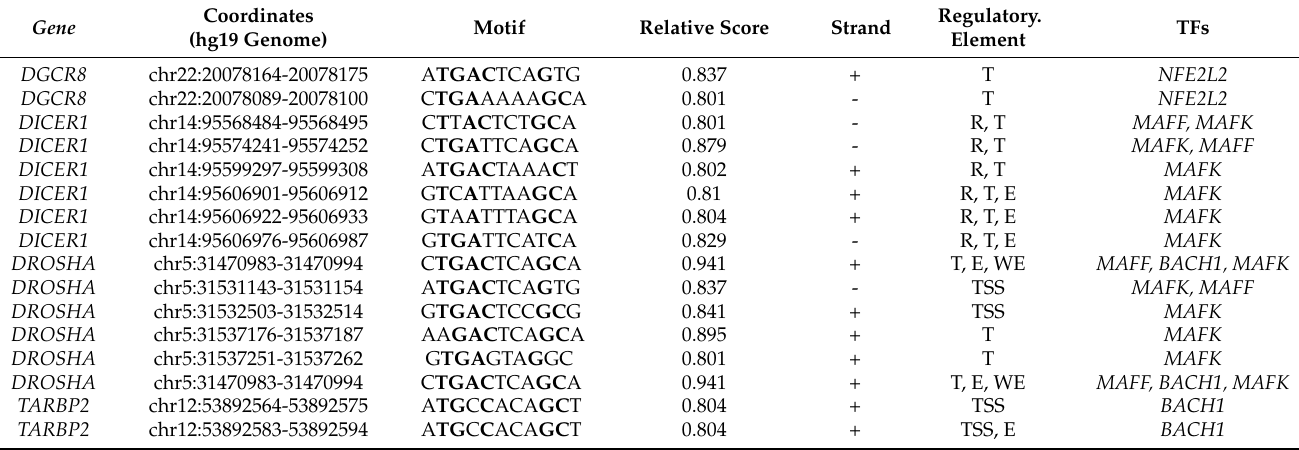
Table 3. Table showing the putative ARE sequences identified in the human genome with a relative score over 80%. Columns and content follow the same format as Table